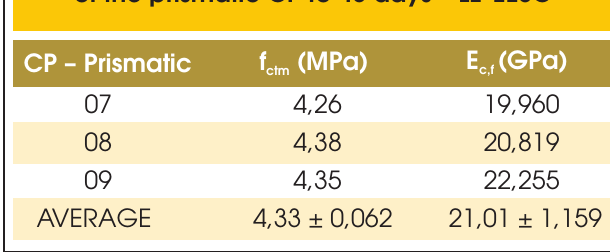
Table 3 – Results of static testing of cylindrical Table 4 – Results of tension testing in flexion